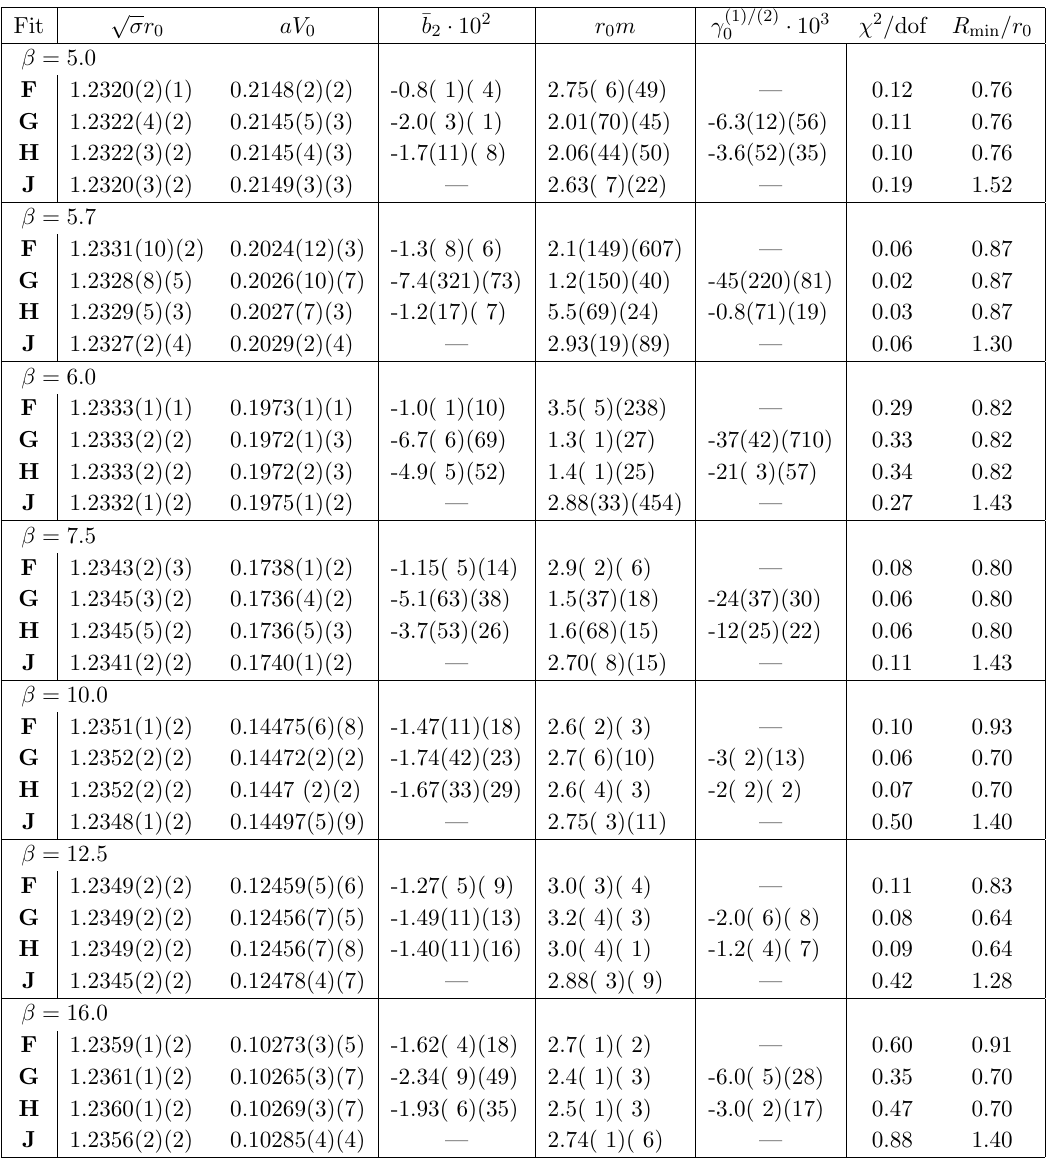
Table 9 . Results of the (cid:12)ts for the extraction of (cid:22) b 2 and m for SU(2) gauge